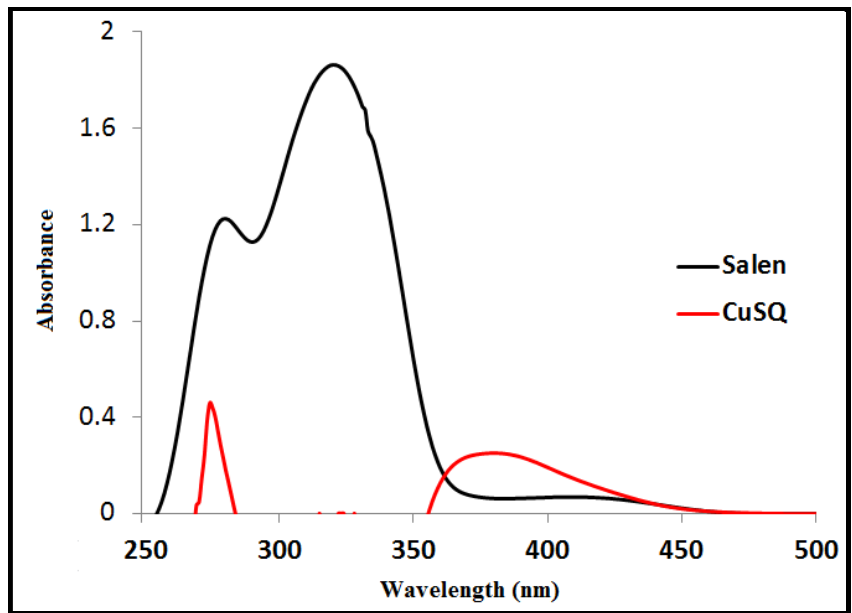
Figure 2. Electronic spectra of Salen ligand and its CuSQ complex in DMSO with concentration 10 − 3 M at 298 K.